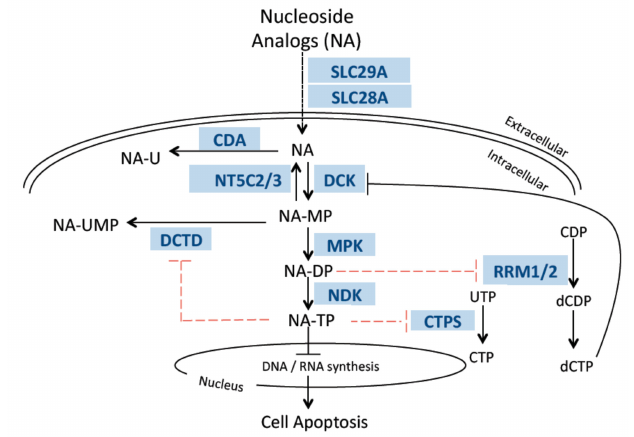
Figure 1. Disposition pathway of nucleoside analogs, cytarabine and clofarabine. DCTD: Deoxycytidylate deaminase, DCK: Deoxycytidine kinase, CDA: Cytidine deaminase, NT5C2 / 3: 5’-Nucleotidase, cytoplasmic, CTPS: CTP synthase, RRM1 / 2: Ribonucleotide reductase, SLC29A: